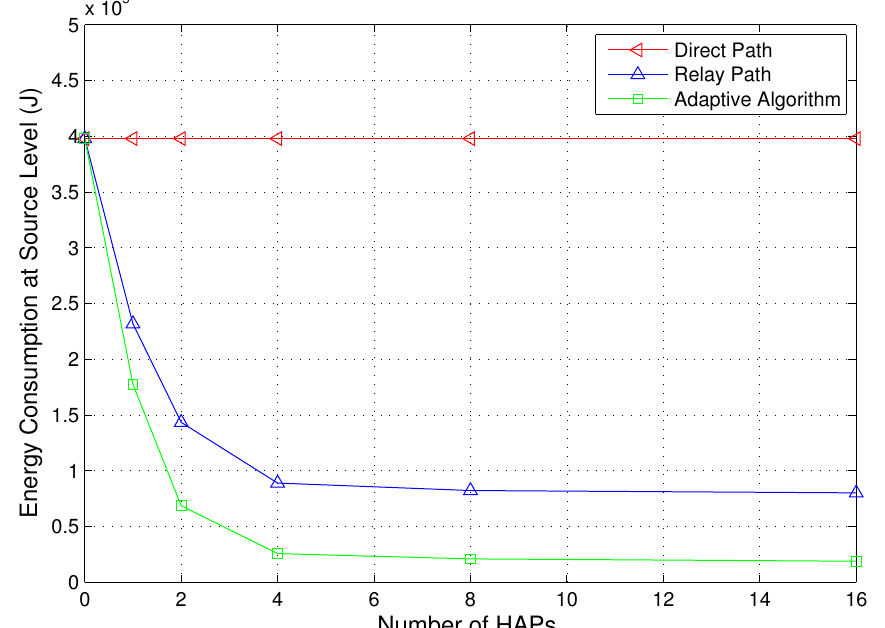
= 500 , κ = 12 dB, κ = 7 dB). T 1 2